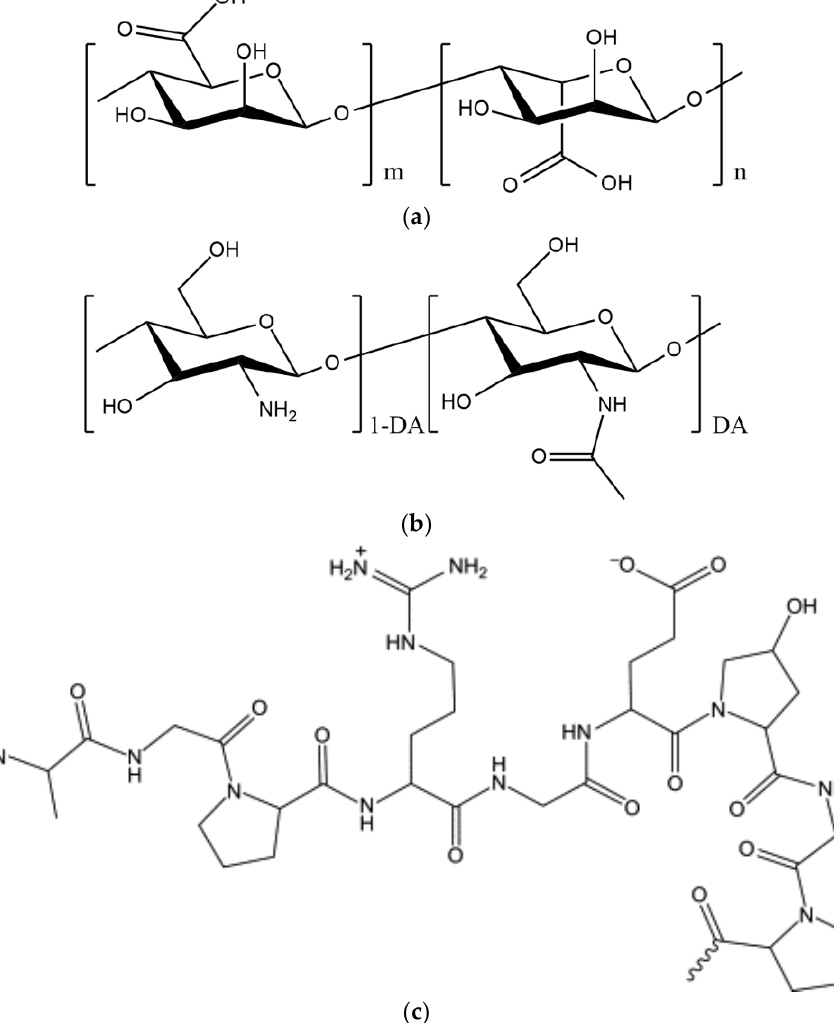
Figure 1. Chemical structures of: ( a ) alginic acid; ( b ) chitin (degree of acetylation, DA ≥ 0.5) and chitosan (DA < 0.5); and ( c ) gelatin.